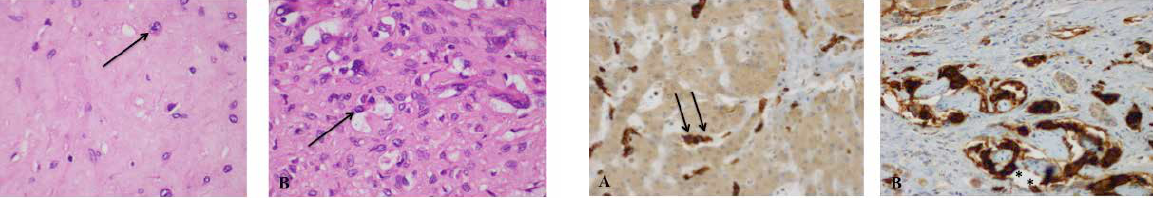
Figure 1: Histochemical features of lesion using Hematoxilin & Eosin- staining. (A)Scantly and abundant myxohyaline stroma. Epithelioid cells appears vacuolized (arrow).Original magnification x 20.(B) Epithelioid cells contained vacuoles signet rings cells-like. Marked nuclear pleomorphism was also observed (arrow). Original magnifi- cation x 40.